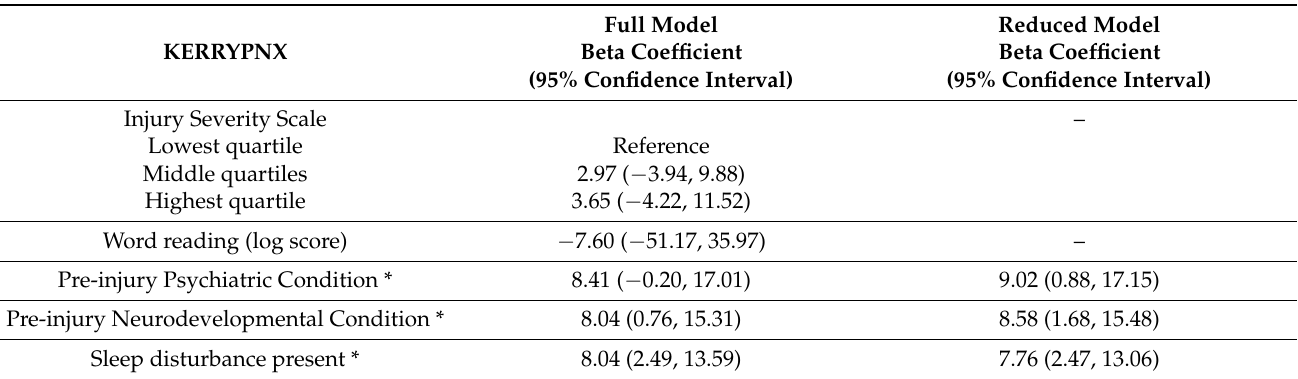
Table 4. Multiple linear regression analysis of Global Executive Composite